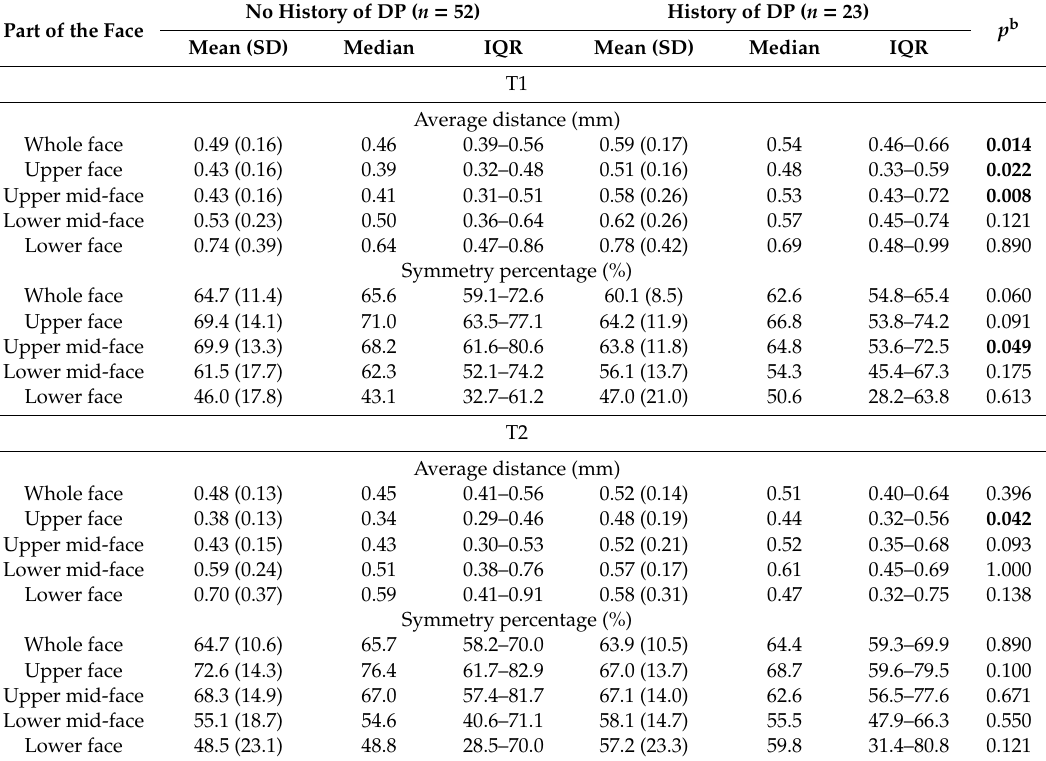
Table 3. Comparison of facial symmetry parameters between the deformational plagiocephaly (DP) group and the controls; Average distance (mm) and symmetry percentage (%) at the age of one year old (T1) and three years old (T2). SD = Standard deviation; IQR = Inter quartile range; Bold values